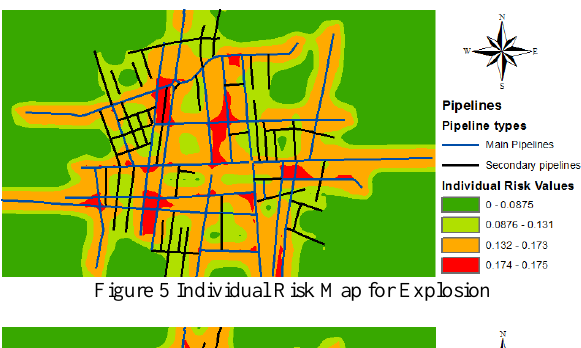
Figure 5 Individual Risk Map for Explosion